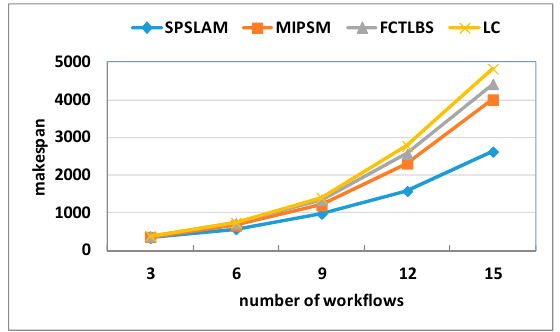
Figure 3. Schedule completion time under different workflow numbers.